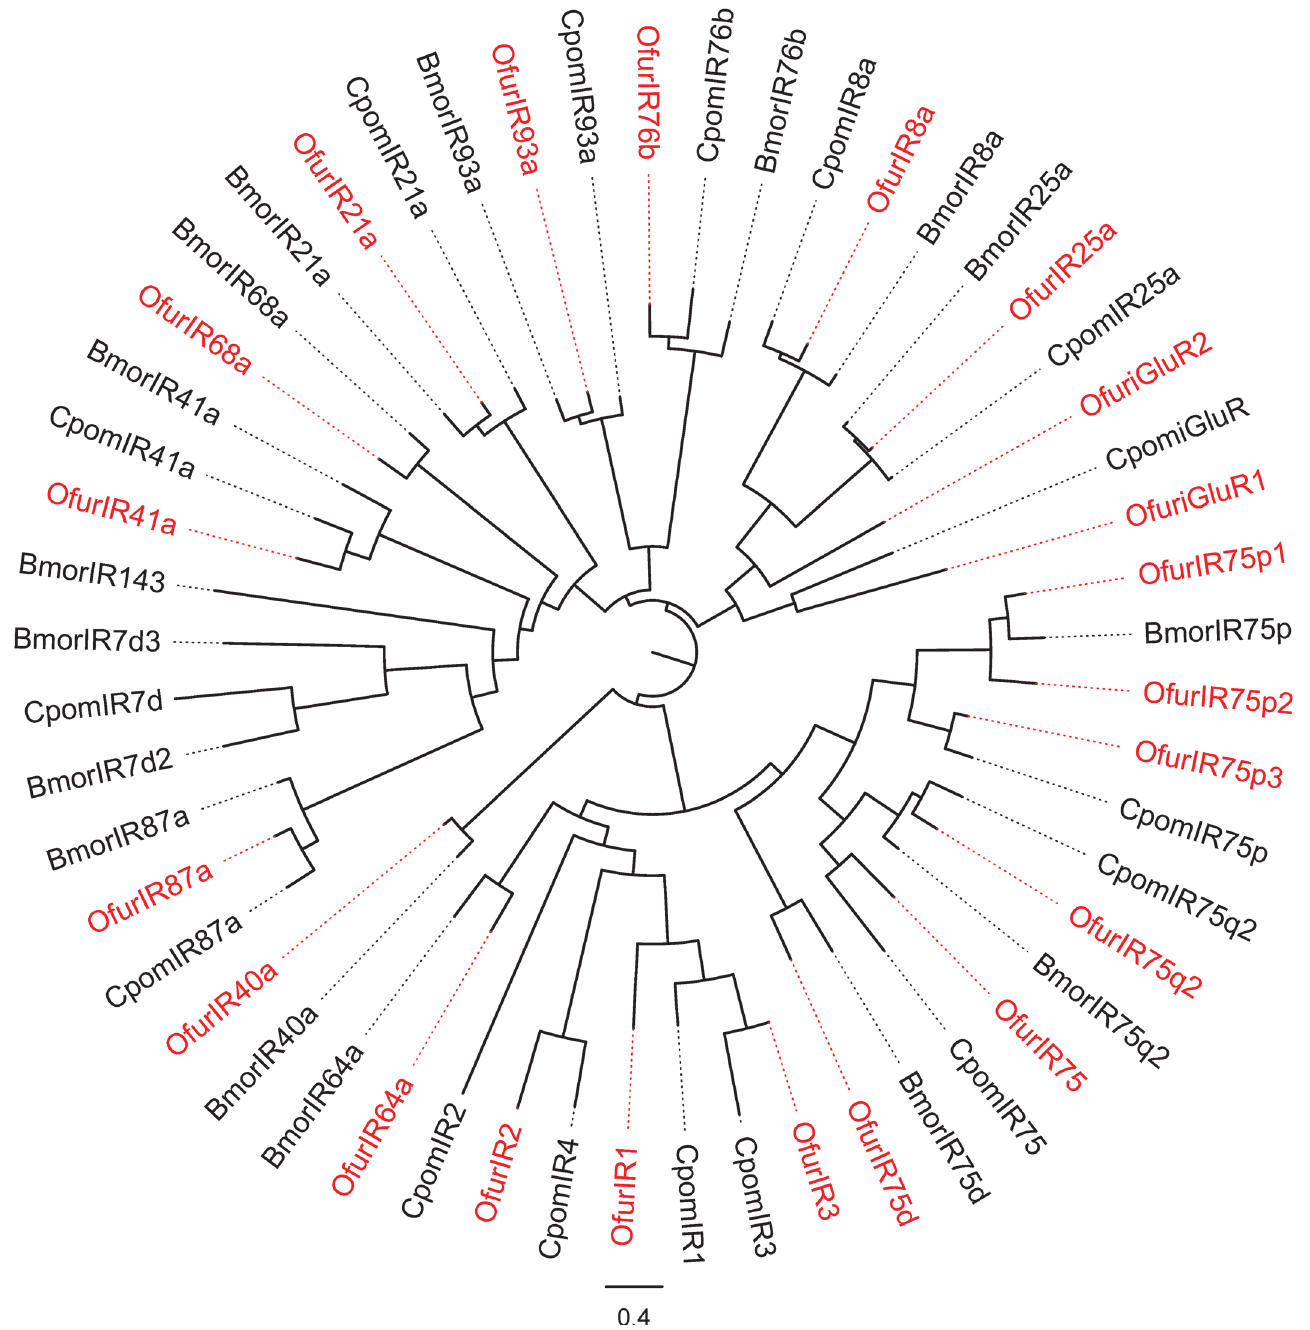
Fig 4. Phylogenetic relationship of O. furnacalis ionotropic receptors ( OfurIRs ) with those of B. mori ( BmorIRs ) and C. pomonella ( CpomIRs ). The tree was constructed by the maximum likelihood method using RAxML and visualized using FigTree. OfurORs are indicated in